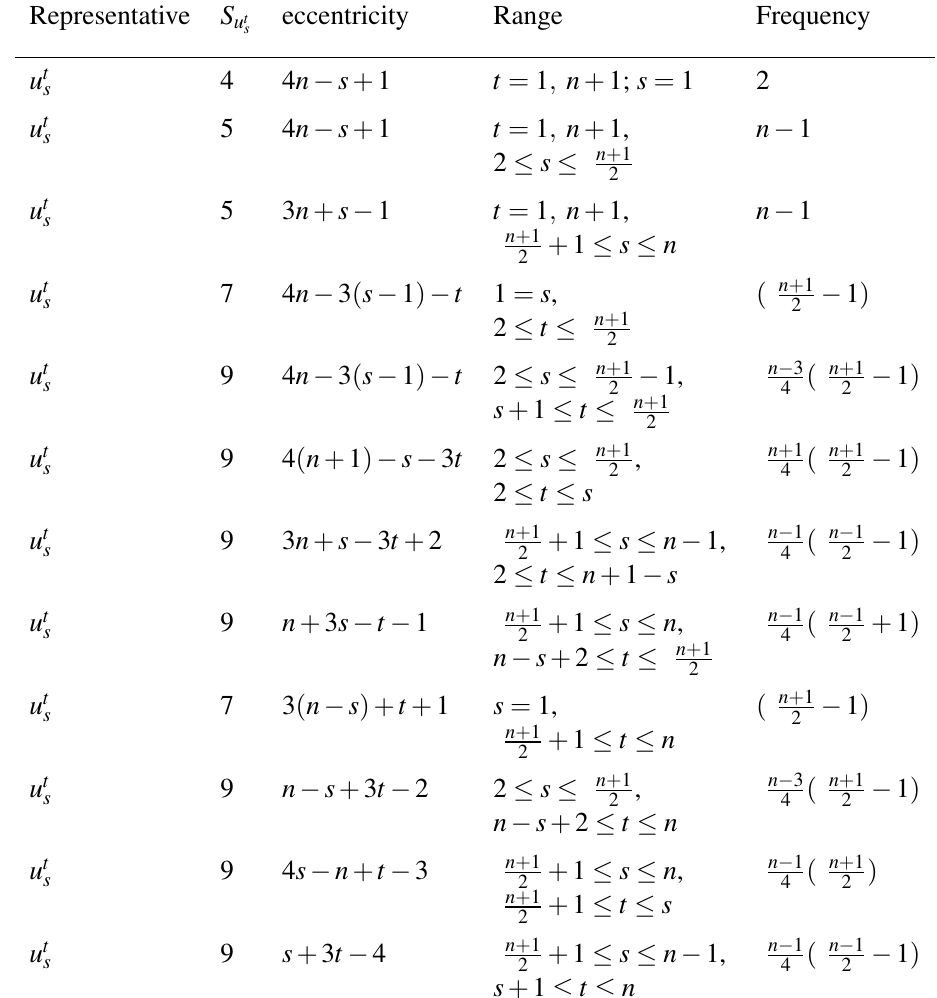
of O m based on degree sum and eccentricity of each vertex when n ≡ 1 ( s n